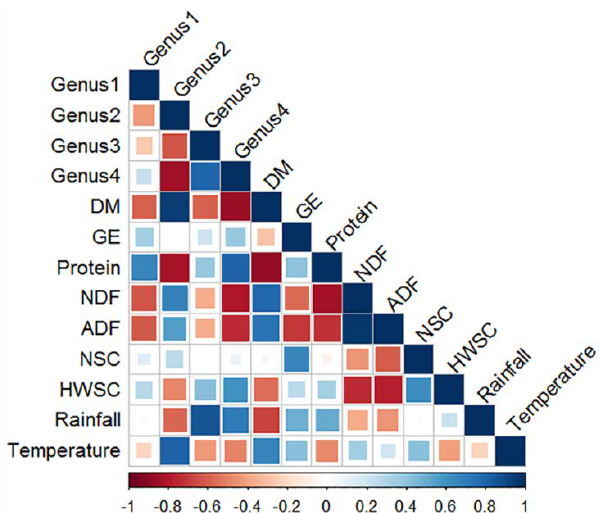
Figure 7. Correlation matrix of bacterial taxa, macro nutrients, and climate variables. Each square on the matrix represents the degree of correlation between two corresponding variables, and is illustrated by the colour intensity and size of the square, as shown on the scale below the matrix; i.e., small light blue to large dark blue squares represent positive correlation from >0 to +1; small light red to large dark red squares represent negative correlation from <0 to − 1. The bacterial taxa included are as follows: Genus1—Unclassified genus within family Ruminococcaceae; Genus2—Unclassified genus within order Bacteroidales; Genus3—Unclassified genus within family Lachnospiraceae; Genus4—Unclassified genus within order Clostridiales. DM—Dry matter (%); GE—Gross energy (KJ/g);